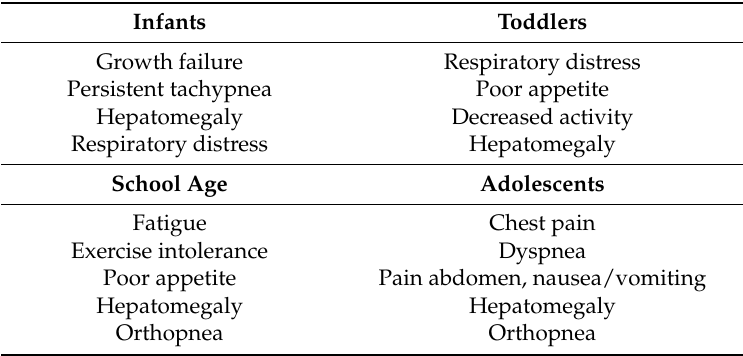
Table 2. Common signs and symptoms of heart failure in children.